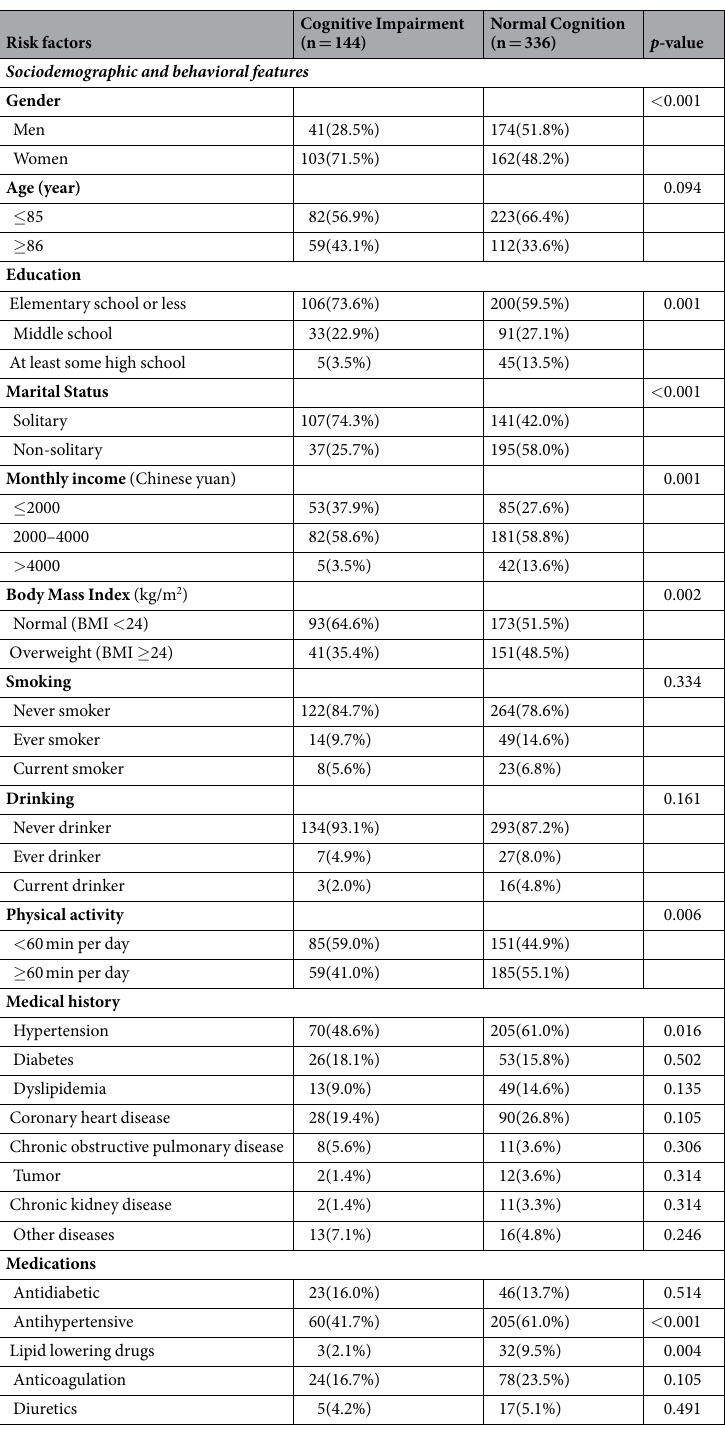
Table 1. Demographic and health characteristics of participants with cognitive impairment vs. normal cognition. Categorical variables were presented as count and column